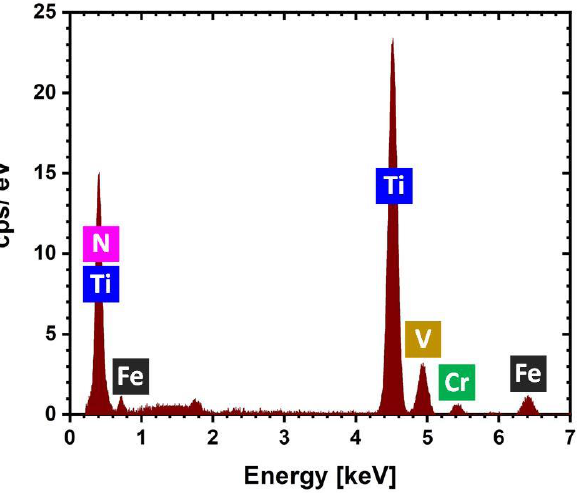
Figure 6. Typical EDS spectrum of duplex-treated samples with TiN deposition temperature of 400 °C.